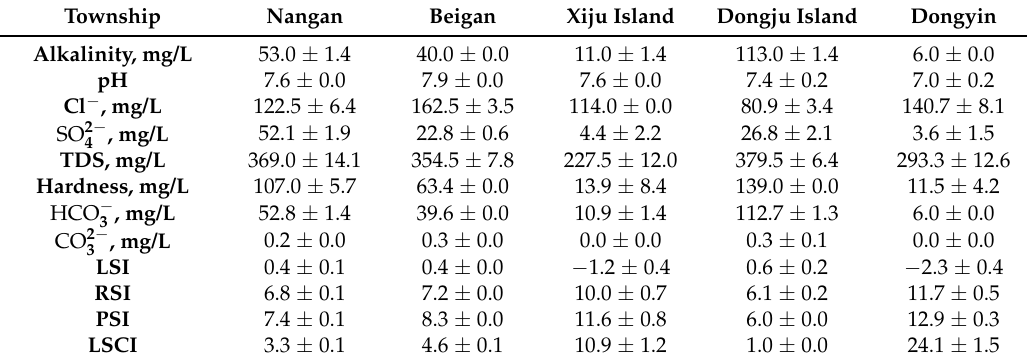
Table 7. Summary of chemical analysis and the water quality index for tap water in Lienchiang.